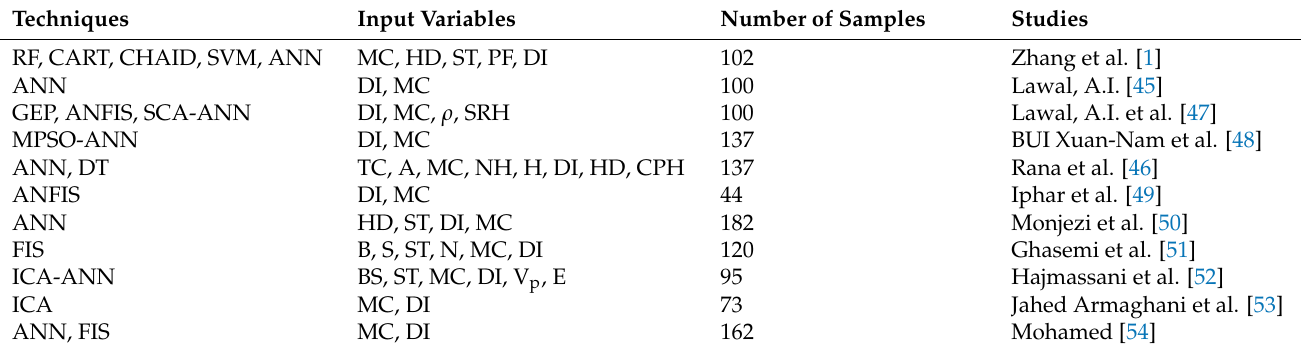
Table 1. Research on blast-induced PPV